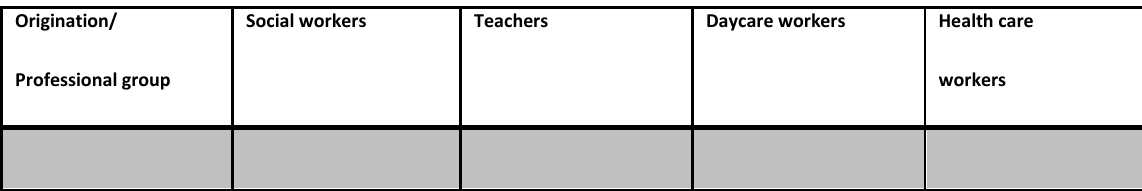
Table 2: Origination of vulnerability, Theilmann & Laursen,